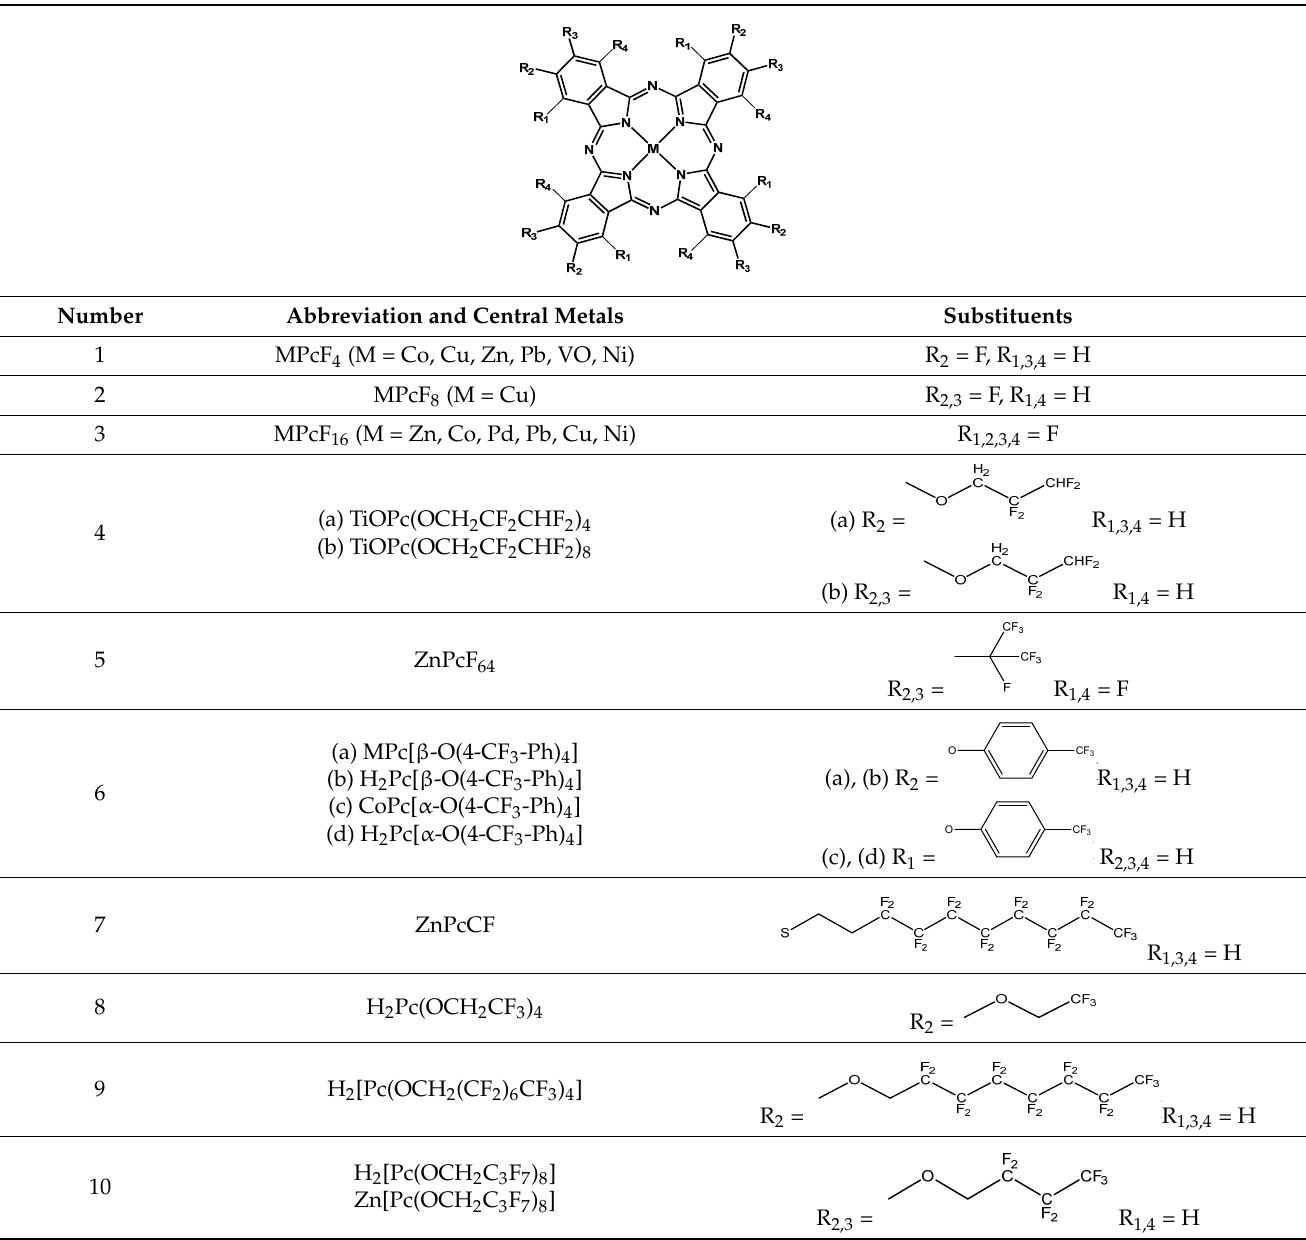
Table 1. Structures of fluoro-substituted phthalocyanines.